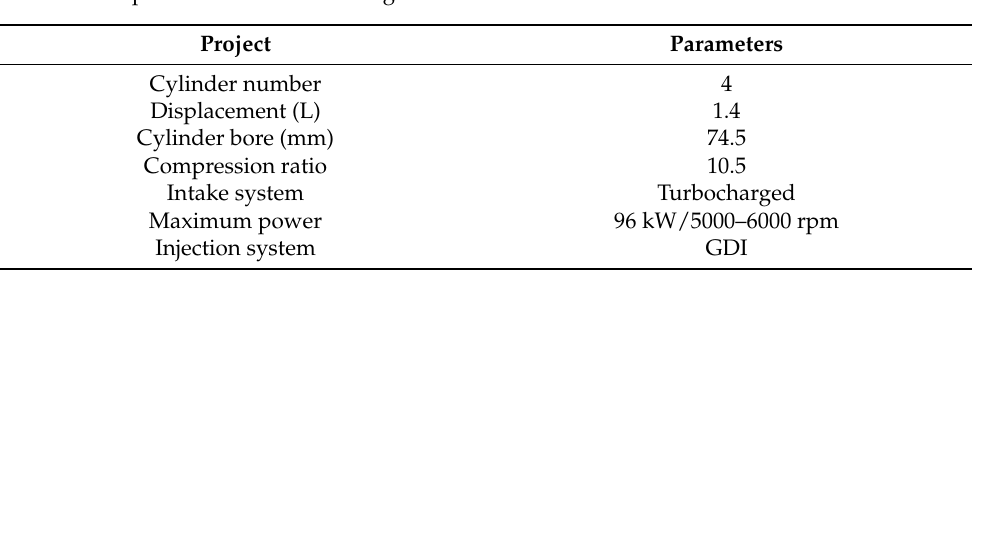
Table 1. Main parameters of the GDI